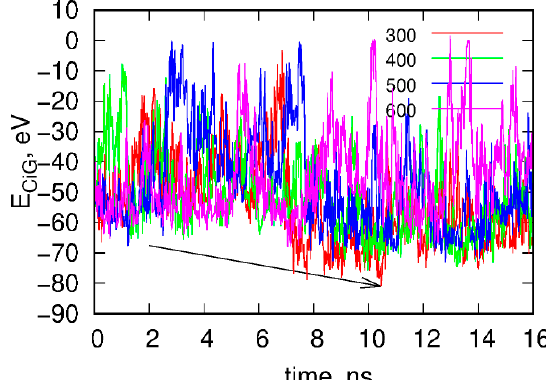
Figure 2. Time dependence of the interaction energy between fCNT and iG, E CiG in the rigid body replica exchange simulations. Note that E CiG does not match the energies from Figure 1. This is due to rescaling of ε ij by a factor of 0.1 and also to the transfer to the implicit solvent model. Each curve shows the energy obtained in a given replica from 300 to 600. The arrow shows the point when the interaction between fCNT and iG is the strongest. The configuration corresponding to this time point is next used as a starting configuration in the explicit solvent of all atom calculations.